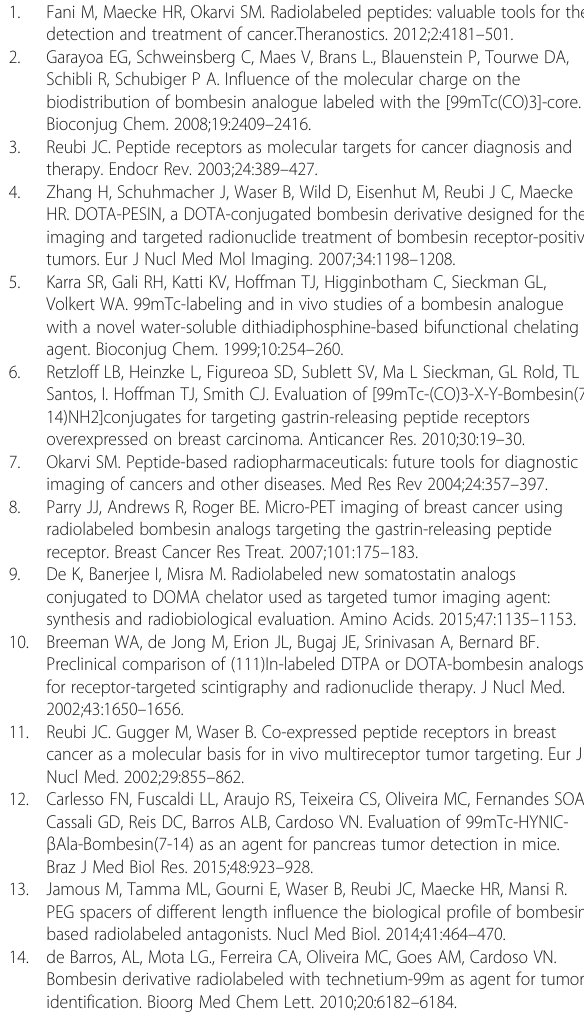
Additional file 1: Figure S1. Chemical structure and MALDI mass of new bombesin peptide analogs. A, HYNIC-Asp-[D-Phe 13 Nle 14 ]BN(7 – 14)NH 2 (BN1); B, HYNIC-Pro-Asp-[D-Tyr 13 Met 14 ]BN(7 – 14)NH 2 (BN2) and C, HYNIC- Asp-Asn-[Lys 5 -D-CHAla 13 Nle 14 ]BN(7 – 14)NH 2 (BN3). Figure S2. Chemical structure of 99m Tc labeled BN1 (A); BN2 (B) and BN3 (C) with the MM2 energy minimized probable molecular structure of 99m Tc-BN1(A ’ ); BN2 (B ′ ) and BN3(C ′ ) (PPTX 3361